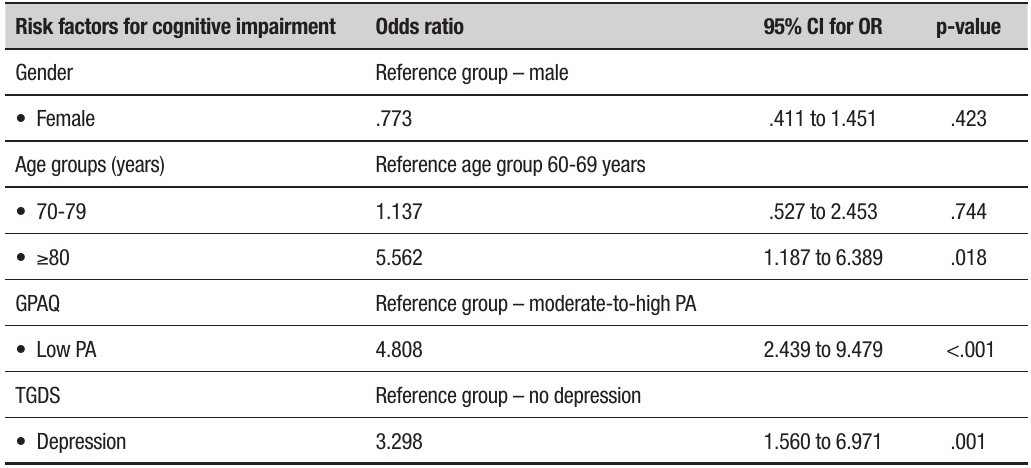
Table 3. Results of logistic regression analysis for risk factors of cognitive impairment. Risk factors for cognitive impairment Odds